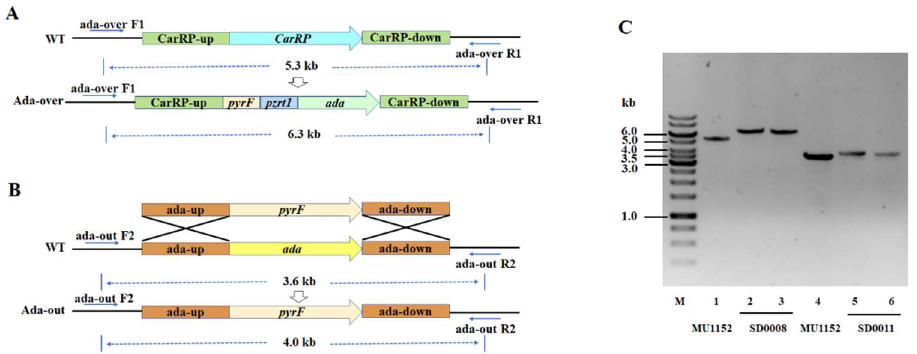
Figure 2. Overexpression and knockout of ada gene. ( A ) The structure of ada -overexpressing plasmid, pCRC8. ( B ) Genomic structure of ada wild-type locus (middle) and upon homologous recombination (lower) with the replacement fragment (upper). ( C ) PCR amplification of the plasmid region in MU1152 (WT), and ada -overexpressing and ada -knockout strains, SD0008 and SD0011.